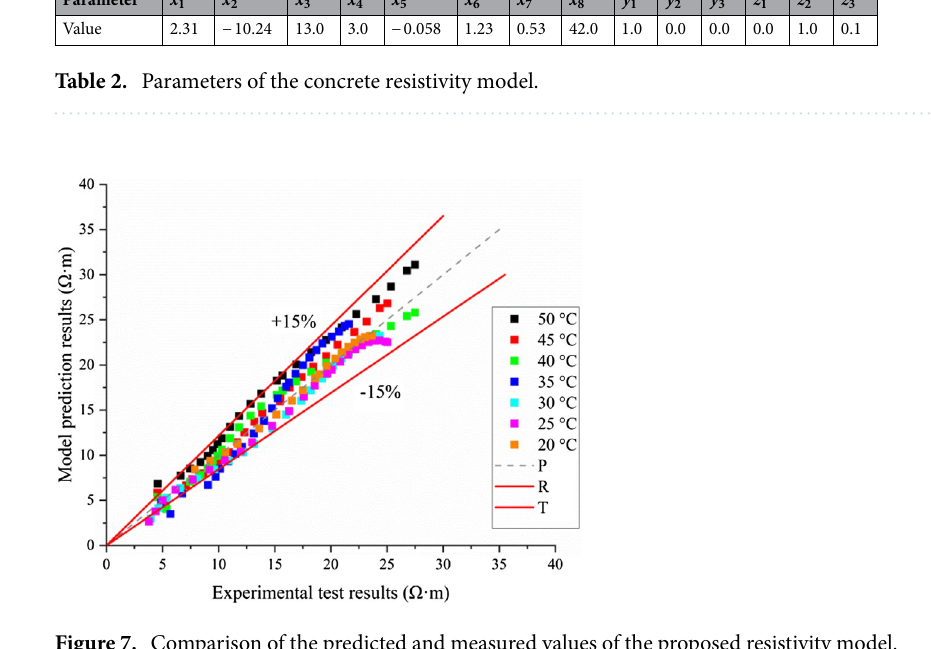
Figure 7. Comparison of the predicted and measured values of the proposed resistivity